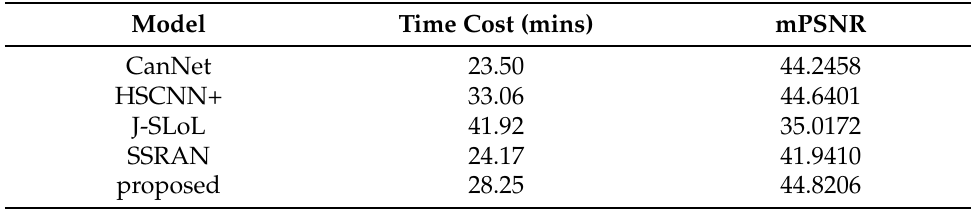
Table 6. The training time of different methods with the ZY1-02D